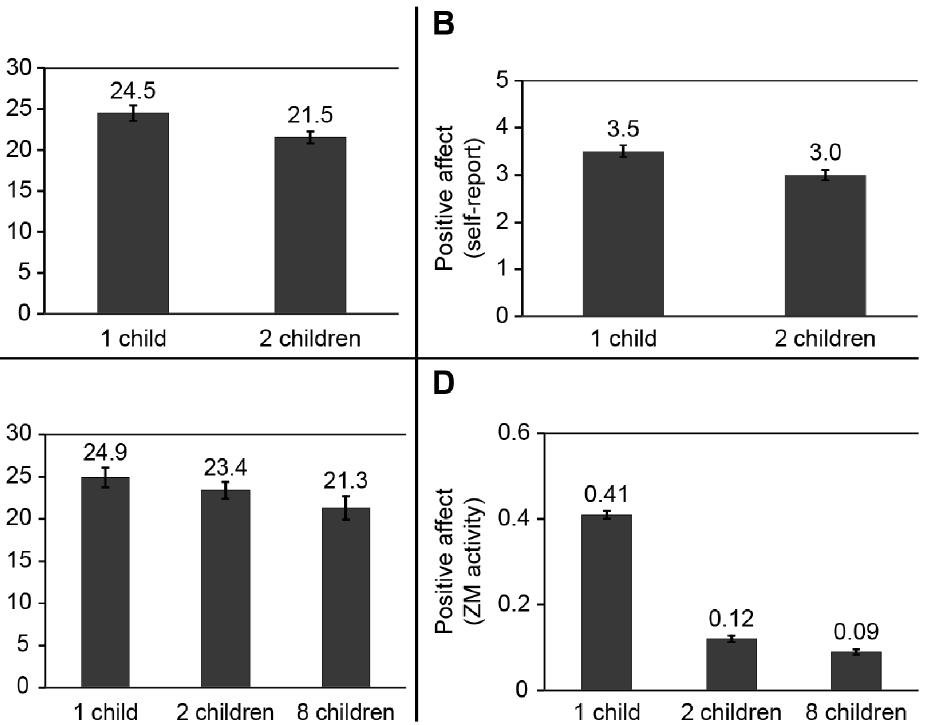
Figure 2. Real donations, self-report, and psychophysiological measures of affect for 1, 2, and 8 children. In Study 1, average donations (in SEK) decreased with increasing number of victims (A) and positive affect was stronger for the single victim (B). In Study 2, donations decreased with more victims (C) and positive affect (facial EMG measurement) decreased with an increasing number of victims (D). ZM activity for one child was significantly greater than for two children ( p , 0.05).